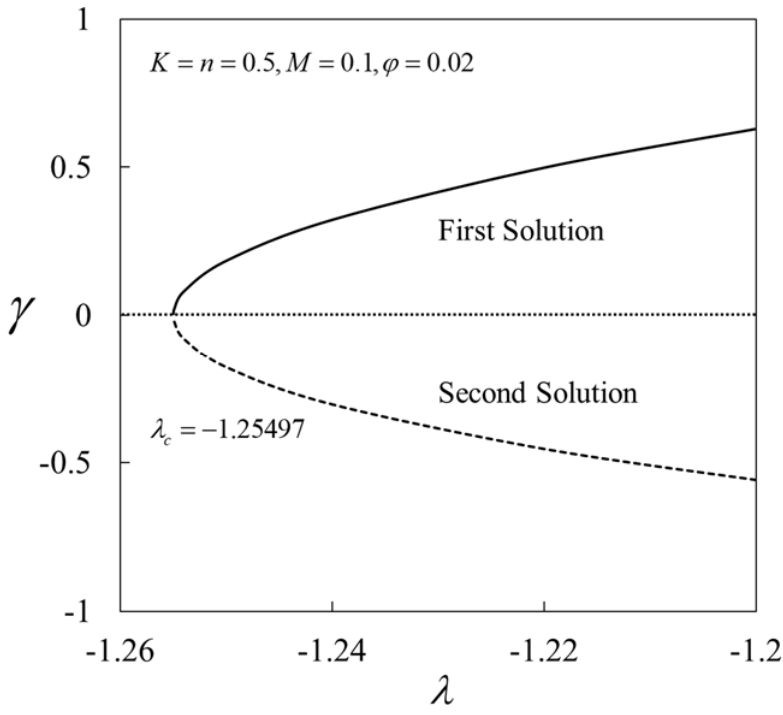
Figure 15. Smallest eigen values of 𝛾 vs. 𝜆 .